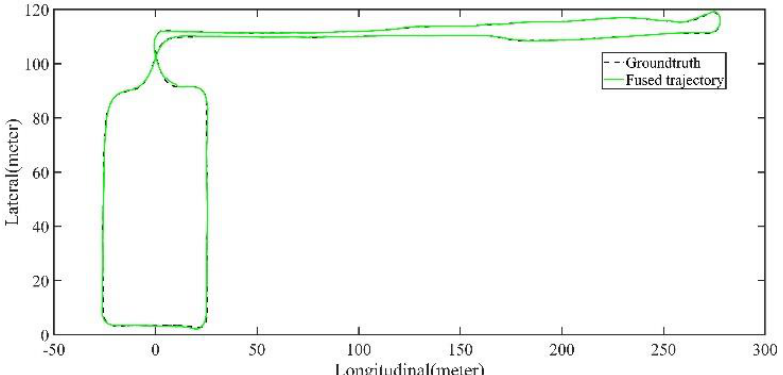
Figure 33. Field test NO.5. Large scale scenario localization test trajectory comparison. The compar- ison of fused trajectory with groundtruth.